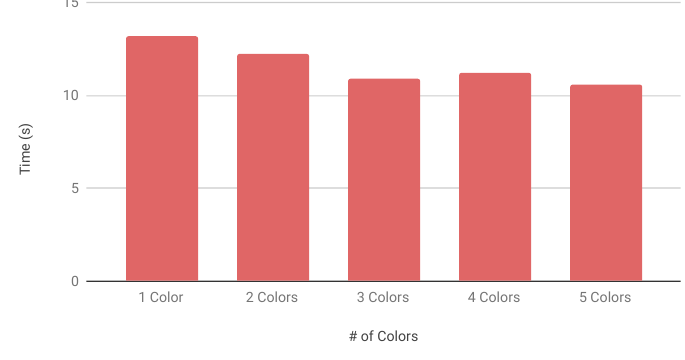
Figure 11. Average object detection time vs. number of colours.